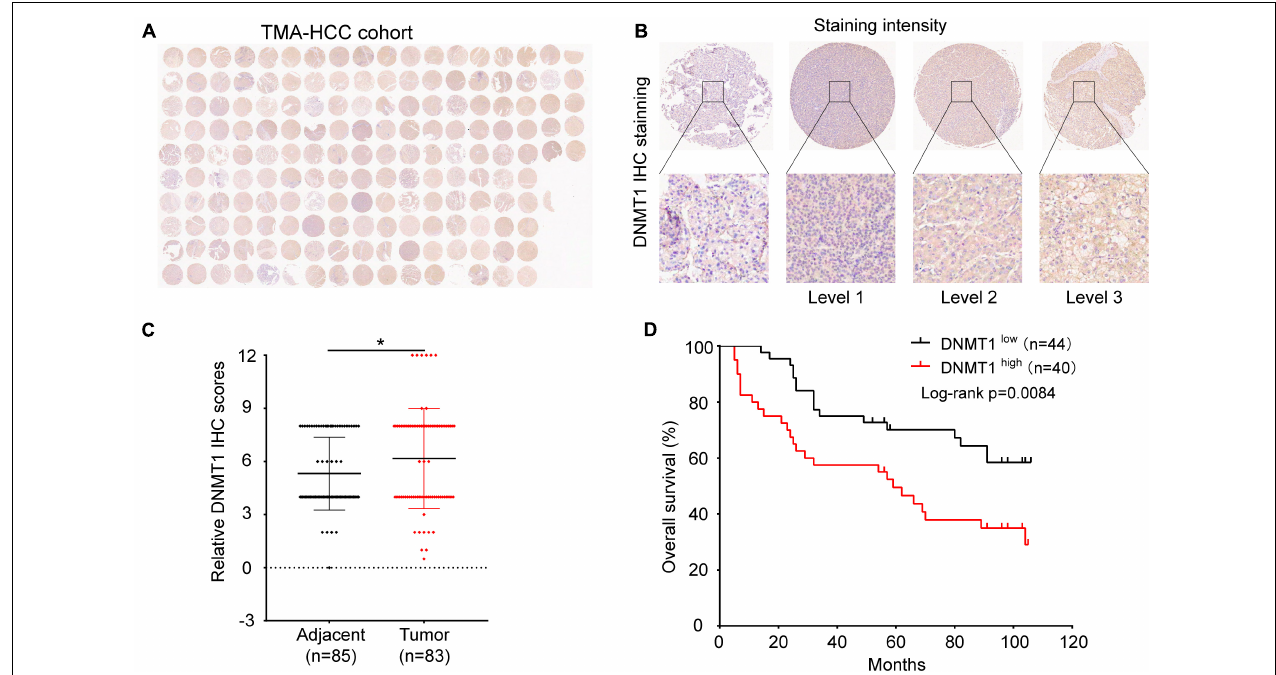
FIGURE 5 | Expression of DNMT1 in human HCC tumour tissues and control tissues. (A) Panoramic scanning of DNMT1 by IHC staining. (B) Representative IHC staining of DNMT1 in samples. (C) The expression of DNMT1 is higher in HCC tissues than in normal tissues. (D) Kaplan–Meier analysis showed that patients with higher levels of DNMT1 had shorter OS times than those with low levels of DNMT1. * p <